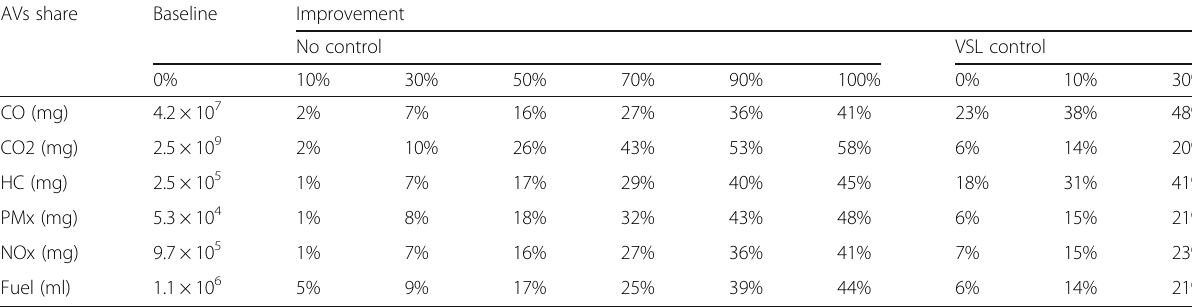
Table 2 Emissions and fuel consumption under lightly congested traffic AVs